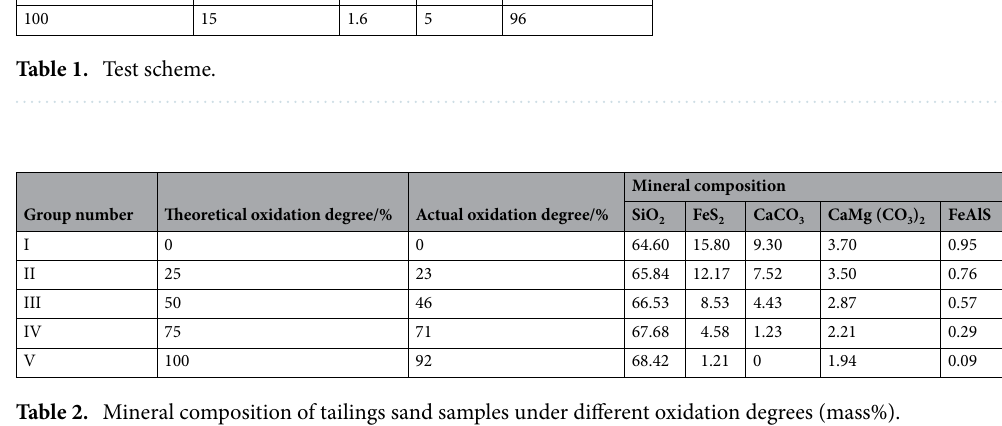
Table 2. Mineral composition of tailings sand samples under different oxidation degrees